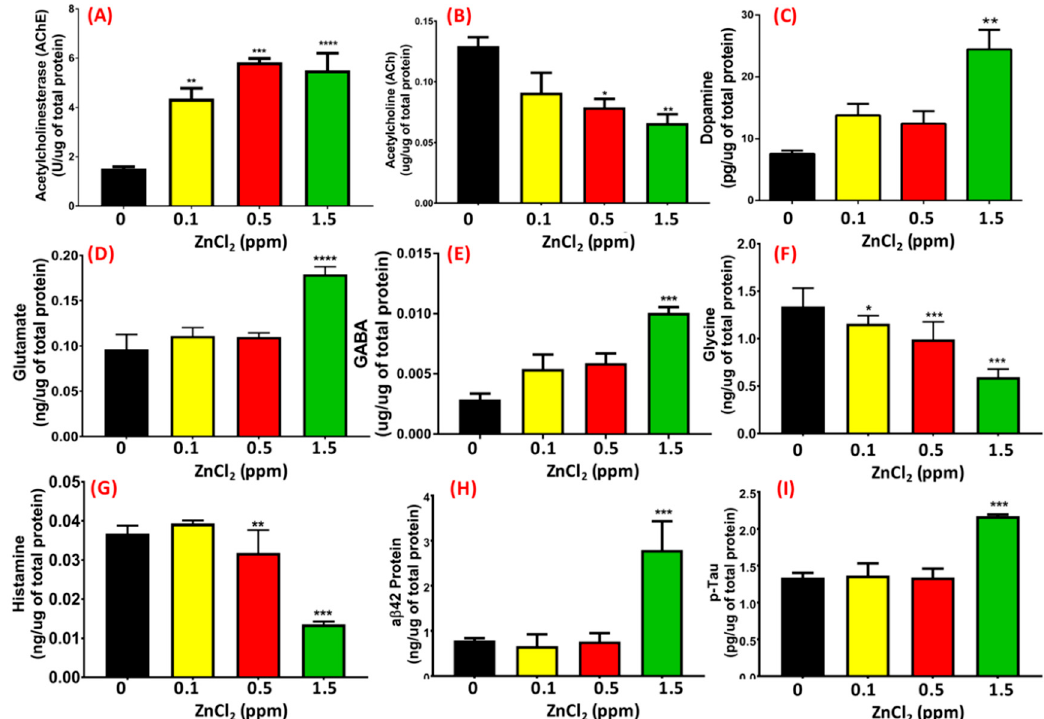
Figure 8. Detection of neurotransmitter levels in the brain. ( A ) Acetylcholinesterase, ( B ) acetylcholine, ( C ) dopamine, ( D ) glutamate, ( E ) gamma-aminobutyric acid (GABA), ( F ) glycine, ( G ) histamine, ( H ) amyloid beta 42 (a β 42), and ( I ) phosphorylated (p)-Tau levels in the brain were measured using ELISA. Data are represented as means ± SEM. Statistical analysis was compared to control using a t -test (* p ≤ 0.05; ** p ≤ 0.01; *** p ≤ 0.001; **** p ≤ 0.0001).